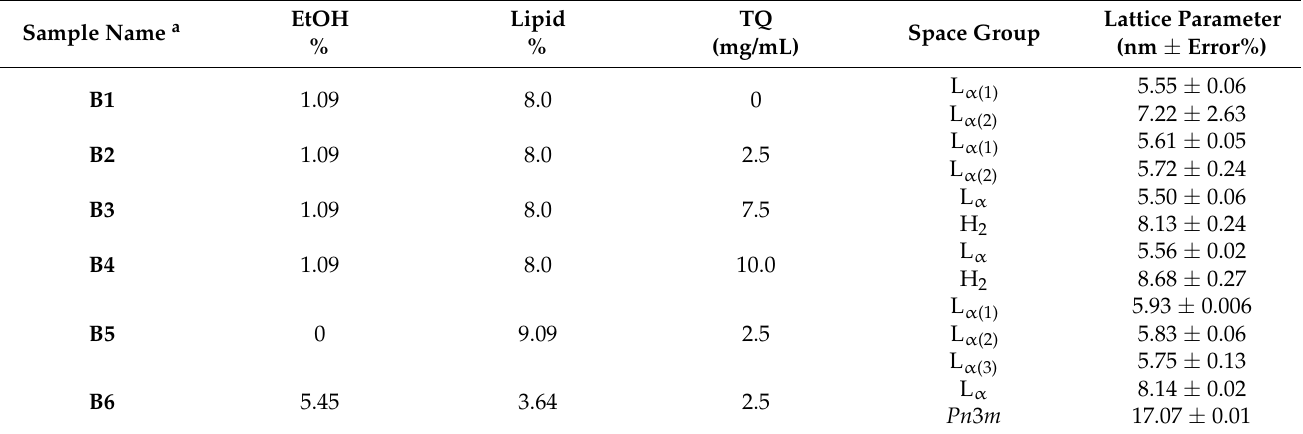
Table 2. Structural features of citrem/SPC nano-self-assemblies produced by employing a low-energy batch emulsification method. For investigating the effects of EtOH and TQ concentrations, synchrotron SAXS experiments were conducted at 25 ◦